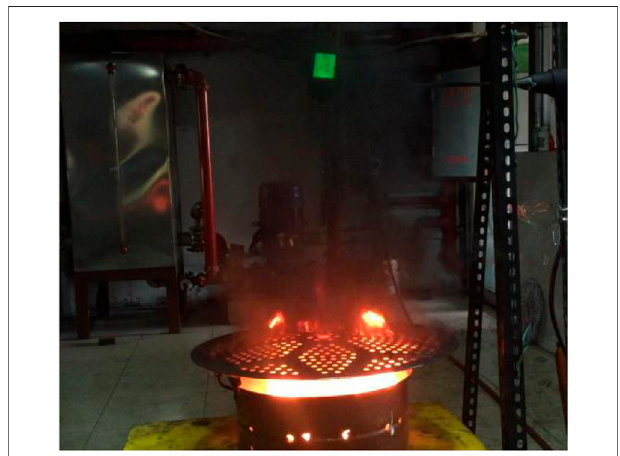
FIGURE 1 | Free-burning experiment.